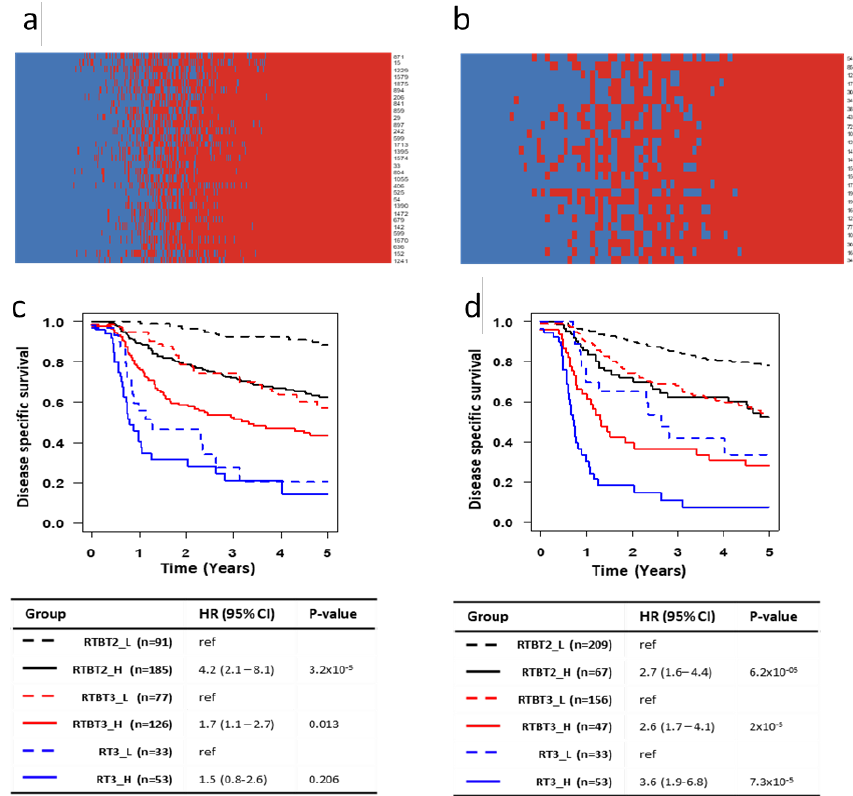
Figure 4. Model consistency and plurality voting for patient classification. ( a , b ) Heatmaps showing the voting by each model (row) on each patient (column). Red: SASP_H; Blue: SASP_L. Voting results are shown for all RTBT2 patients by RTBT2 models ( a ) and RT# patients by RT3 models ( b ). ( c ) Kaplan-Meir survival curves for SASP_H and SASP_L subsets in each of the three datasets (RTBT2, RTBT3 and RT3). SASP groups were defined by plurality voting of all 31 RTBT3 Ridge models. A patient is considered as SASP_H if >50% of the models voted the patient as SASP_H. ( d ) Kaplan-Meir survival curves for SASP_H and SASP_L subsets in each of the three datasets (RTBT2, RTBT3 and RT3). SASP groups were defined by plurality voting of all 25 RT3 Ridge models. A patient is considered as SASP_H if >50% of the models voted the patient as SASP_H.